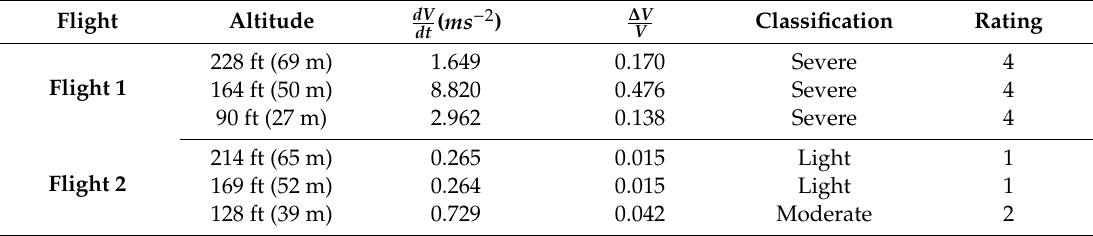
Table 2. Classification of wind shear intensity for three lowest altitudes in Flights 1 and 2.